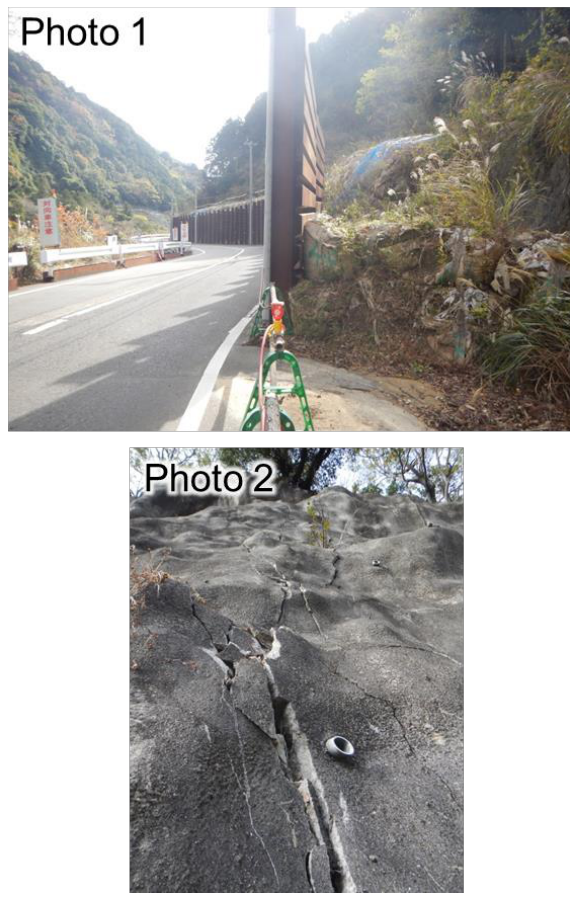
Figure 5. Field photos in Tanabe site. (Photo 1: road replacement, Photo 2: fresh open crack of mortar spraying